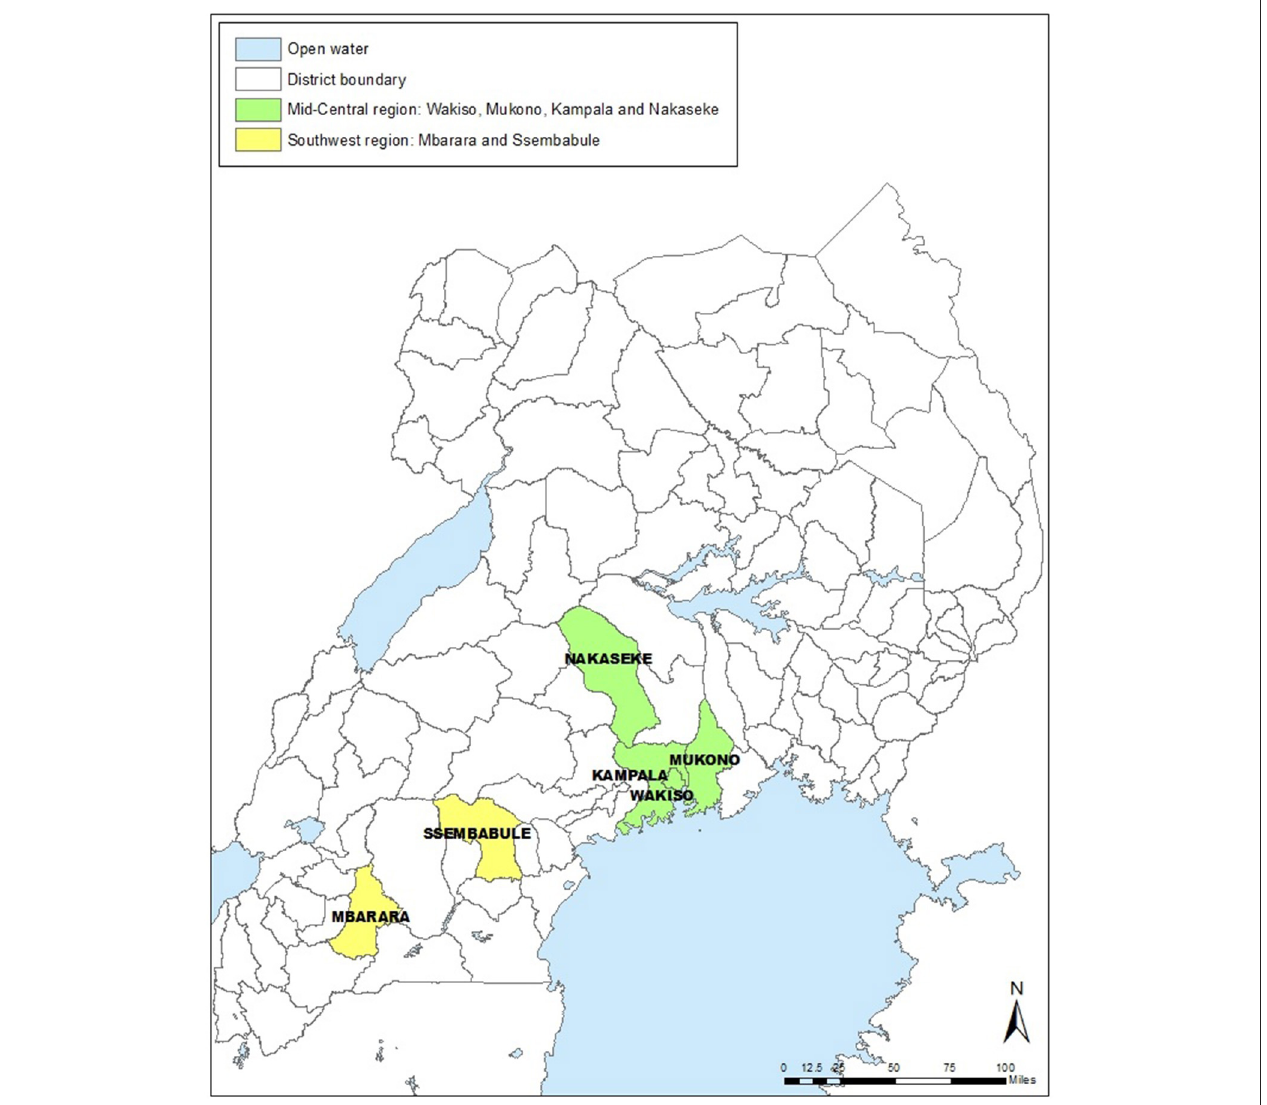
FIGURE 1 | Map of Uganda showing study area. Mid-Central region: Wakiso, Mukono, Kampala, and Nakaseke districts. Southwest region: Mbarara and Ssembabule districts.